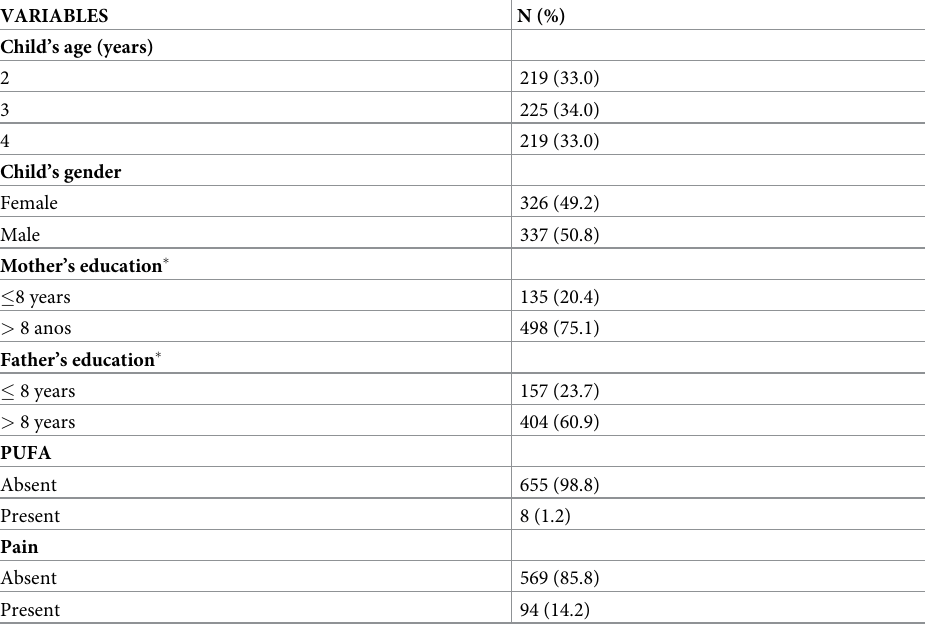
Table 3. Socioeconomic and clinical characteristics of the sample (n = 663).